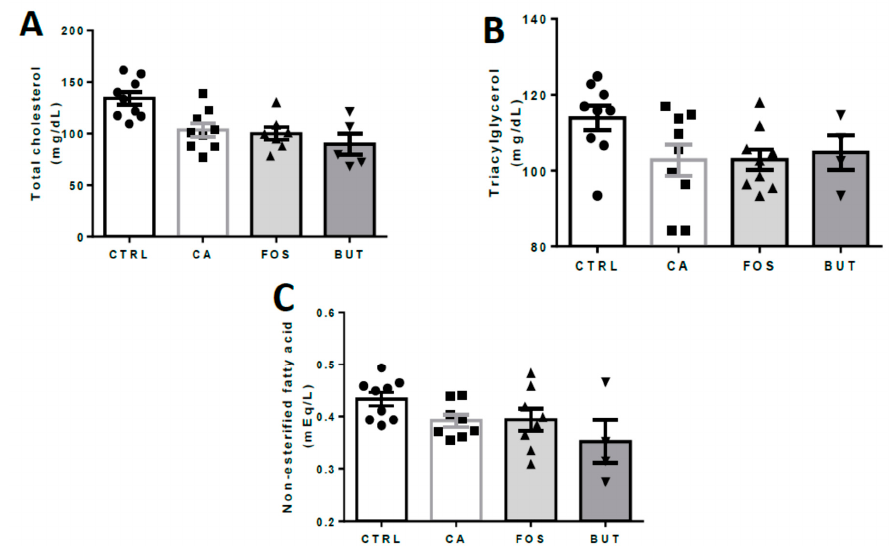
Figure 4. Lipid profile: total cholesterol ( A ), triacylglycerol ( B ), and non-esterified fatty acid ( C ). Mice were divided into four groups: control group (CTRL— n = 9–10) fed with chow diet; and colon carcinogenesis-induced groups fed either with chow diet (CA— n = 9–10), TB-supplemented diet (BUT— n = 5–6), or with FOS-supplemented diet (FOS— n = 9–10). Colon carcinogenesis was induced chemically by azoxymethane (AOM)/dextran sodium sulphate (DSS). Data are presented as means ± SEM. After outlier exclusion, the groups were compared using one-way ANOVA followed by Bonferroni post hoc tests; black circles ( ● ), square ( ∎ ), triangles ( ▲ ) , inverted triangles ( ▼ ) represents sample numbers in the corresponding group. Nutrients 2019 , 11 , x FOR PEER REVIEW